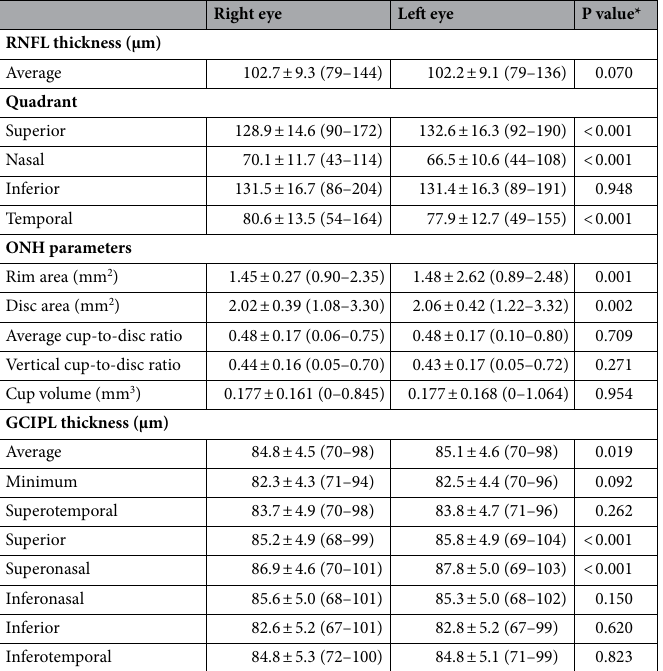
The interocular differences in OCT parameters. The interocular differences in OCT parameters between the right and left eyes are presented in Table 1. The mean average RNFL thickness was 102.7 ± 9.3 μm in the right eye and 102.2 ± 9.1 μm in the left eye. The right eyes showed thinner superior quadrant RNFL, thicker nasal and temporal quadrant RNFL (P < 0.001). Among the ONH parameters, the right eyes showed lesser rim (P = 0.001) and disc areas (P = 0.002); cup-to-disc ratio and cup volume did not show significant differences (P > 0.05). Regarding the macular GCIPL thickness, the right eyes had a thinner GCIPL in average, superior, and superonasal sectors compared to the left eyes (P < 0.05). The distribution of interocular difference in the average RNFL thickness, average GCIPL thickness, rim area, and average cup-to-disc ratio between the right and left eyes is presented in Fig. 1. The percentile distribution of the interocular differences in the OCT parameters between the right and left eyes is shown in Table 2. The 2.5th and 97.5th percentile interocular difference tolerance limits were − 9.0 μm and 11.0 μm for the average RNFL thickness, − 0.21 and 0.18 for average cup-to-disc ratio, and − 4.0 μm and 4.0 μm for average GCIPL thickness, respectively. Affecting factors for the interocular differences. The age was not significantly associated with interocular differences in the OCT parameters (P > 0.05). Interocular differences in the refractive error were significantly associated with interocular differences in the average RNFL thickness (P < 0.001), average GCIPL thickness (P < 0.001), disc area (P = 0.043), and rim area (P < 0.001, Table 3, Fig. 2). However, the average cup- to-disc ratio (P = 0.847), vertical cup-to-disc ratio (P = 0.538), and cup volume (P = 0.776) were not significantly associated with interocular differences in the refractive error. Interocular differences in the disc size were signifi- cantly associated with interocular differences in the rim area (P < 0.001), average cup-to-disc ratio (P < 0.001), vertical cup-to-disc ratio (P < 0.001), and cup volume (P < 0.001, Table 3). No significant difference was found in any of the OCT parameters when the interocular difference was compared between females and males (P > 0.05).